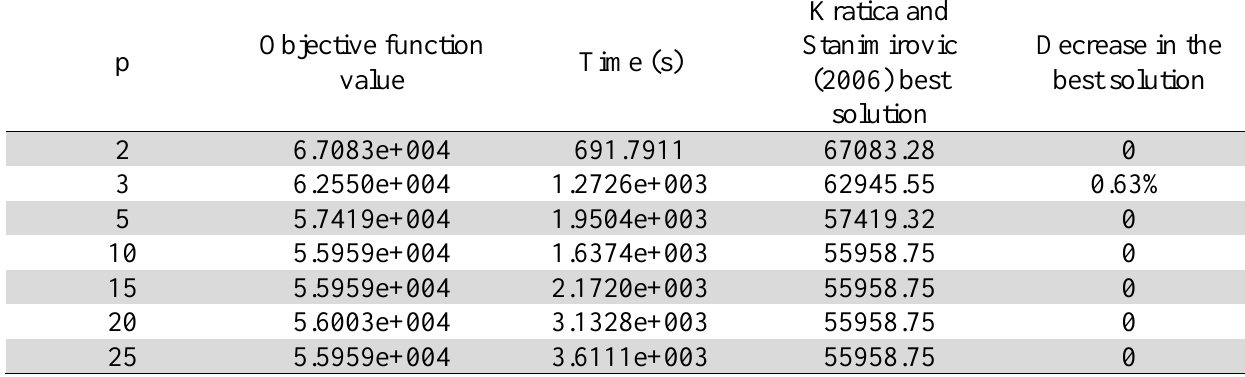
Results of the SA for different AP data set